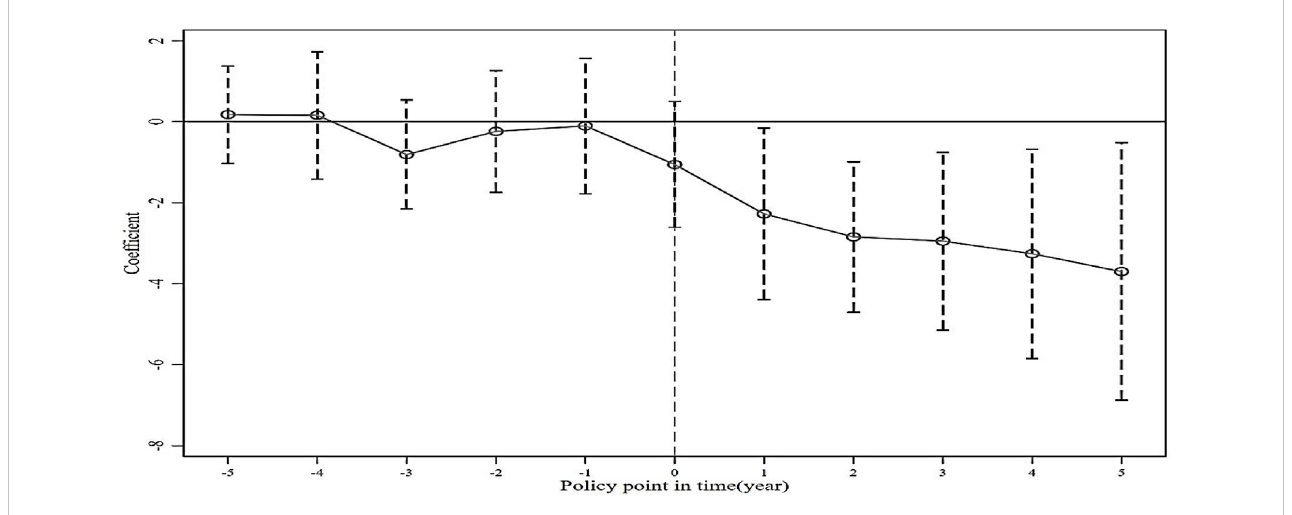
FIGURE 5 Time dynamic effect analysis of NEDC policy.